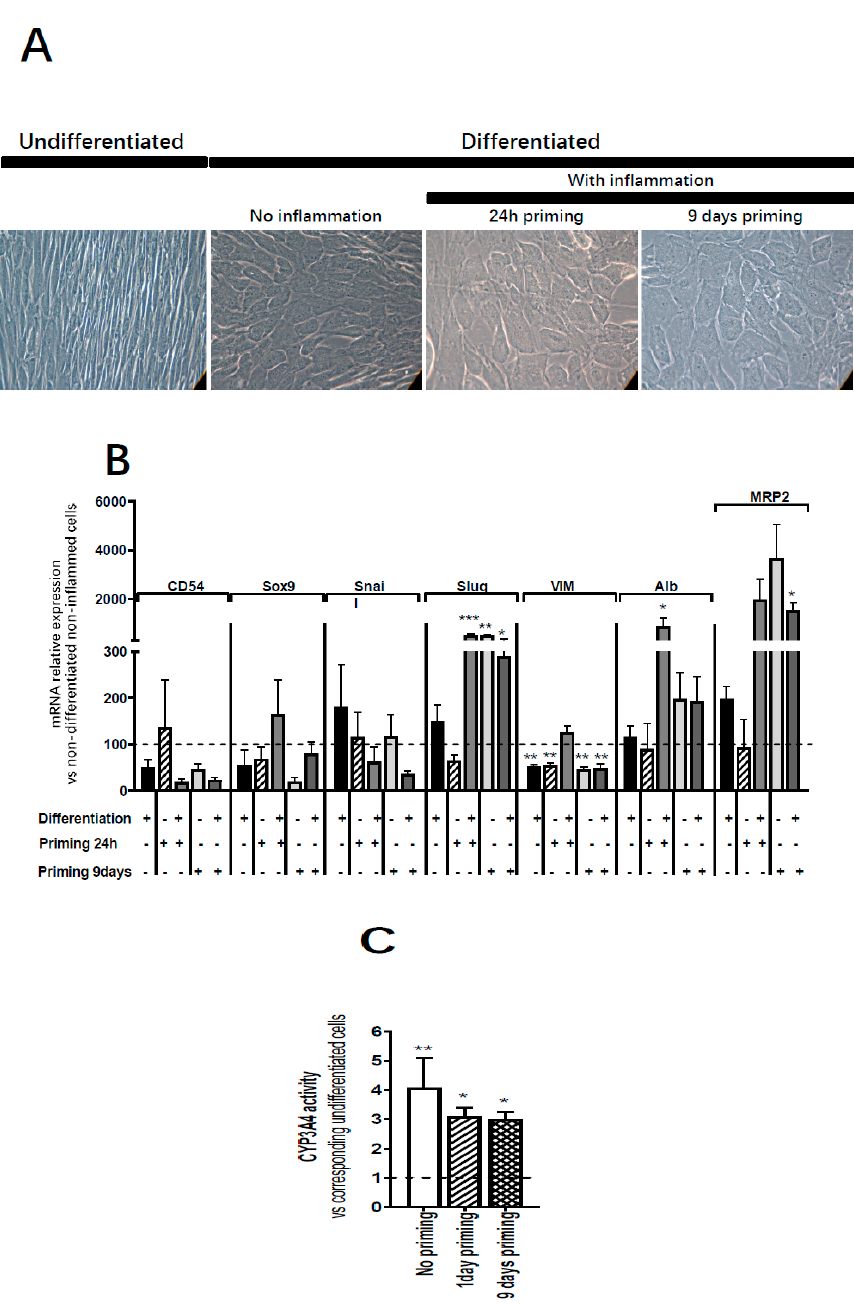
Figure 7. Effect of inflammation on ADHLSC hepatocytic differentiation potential. ( A ) Primed ADHLSC acquired polygonal shape with granular cytoplasm after in vitro hepatocytic differentiation similar to the standard condition. Magnification: 200×. ( B ) RT-qPCR gene expression analysis demonstrated that inflammation did not alter the mRNA expression of mesenchymal markers except for slug and vimentin. Slug expression remains upregulated in differentiated 24 h-primed cells and both undifferentiated and differentiated 9-day primed cells while the expression of vimentin remains